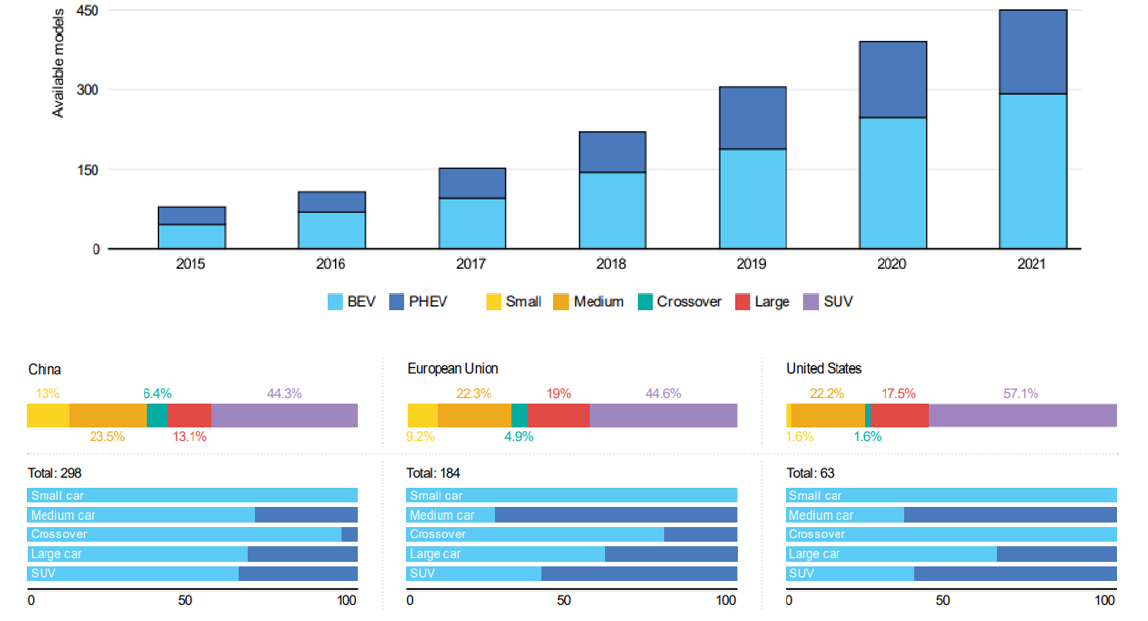
Figure 6. Status and evolution of electric vehicle model availability 2015–2021 [62].